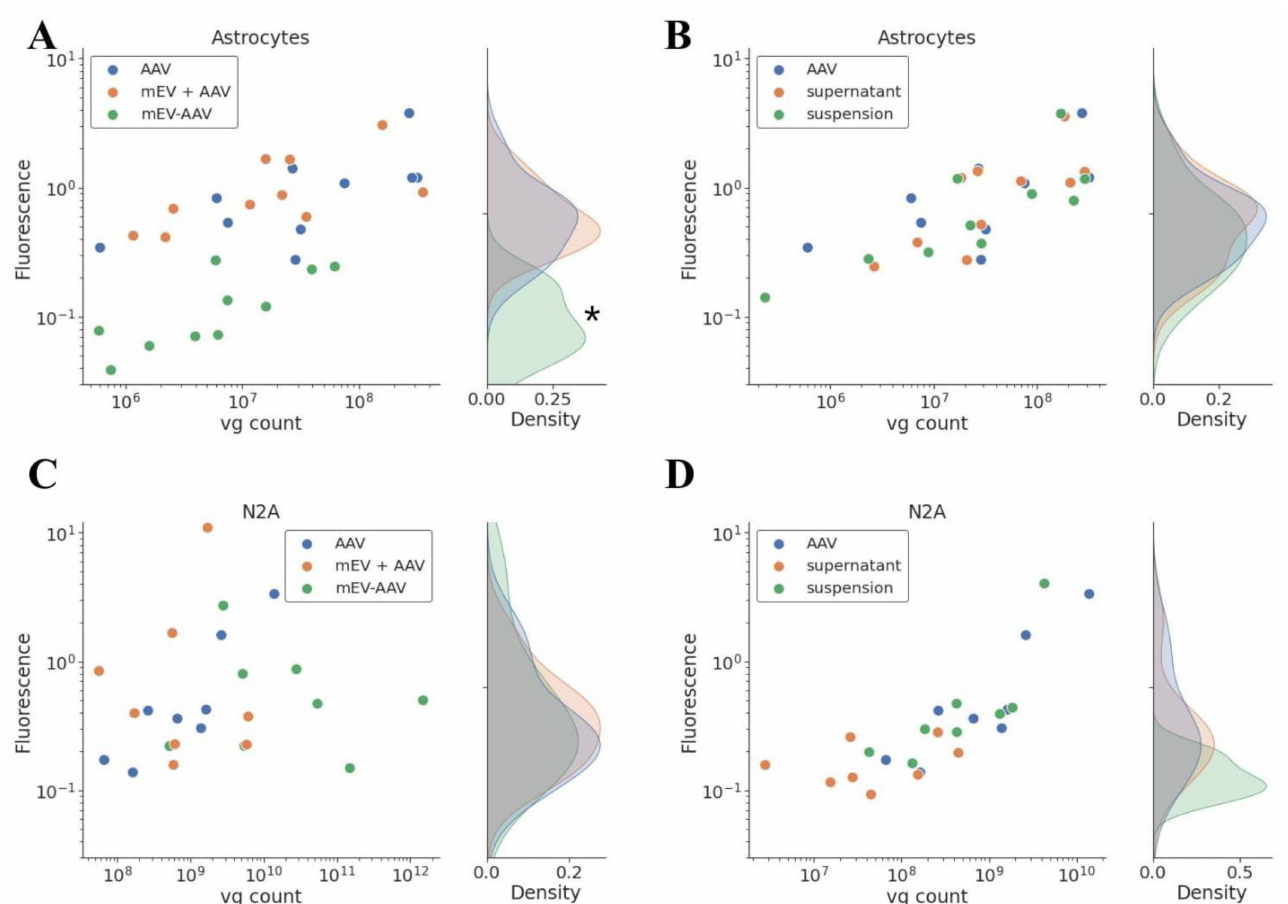
Figure 3. Quantitative analysis of transgene expression. Measured fluorescence was represented with applied vg. EV- packaging reduced the infection capacity of the AAV particles in primary astrocyte cells. Mixing the AAV with EV did not influence the effectiveness. ( A ) Primary astrocytes, “AAV”, “mEV + AAV”, and “mEV-AAV” treatment, n = 5, * indicates significant difference between “mEV-AAV” and “AAV” transduction efficiency, p < 0.0001. ( B ) Primary astrocytes, “AAV”, “supernatant”, and “suspension” treatment, n = 5. ( C ) N2A cell culture, “AAV”, “mEV + AAV”, and “mEV-AAV” treatment, n = 4. ( D ) N2A cell culture. “AAV”, “supernatant”, and “suspension” treatment, n =